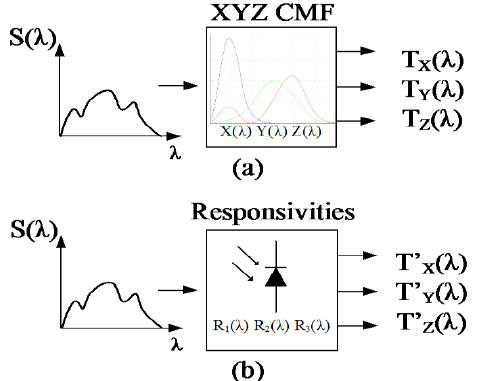
Figure 13. Generation of the T X , T Y , T Z and T’ X , T’ Y , T’ Z